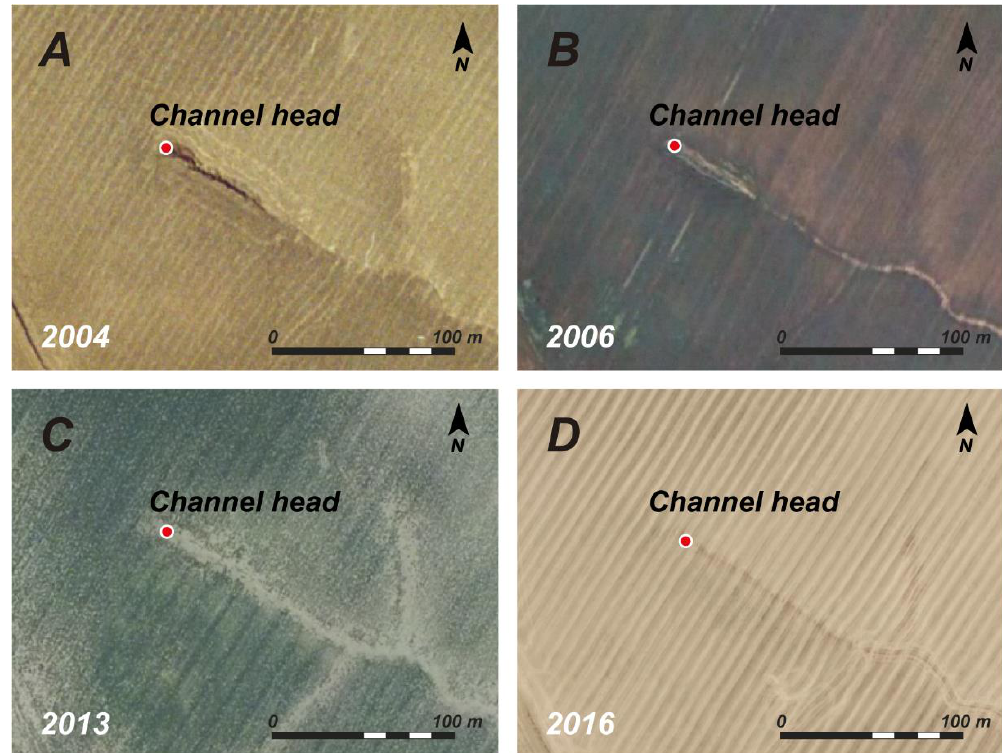
Figure 10. ( A – D ) orthoimages of channel 17 (catchment A) captured in 2004, 2006, 2013, and 2016, respectively. The channel’s head appears at almost the same location in all four orthoimages. The channel’s cross section has become filled and the topography flattened in this section throughout the years due to the effect of repeated annual ploughing.